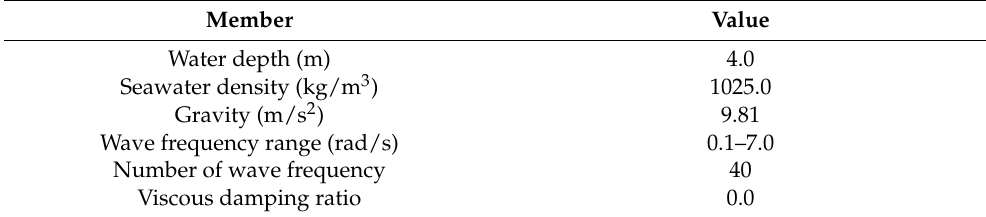
Table 4. Conditions for hydrodynamic frequency response analysis.